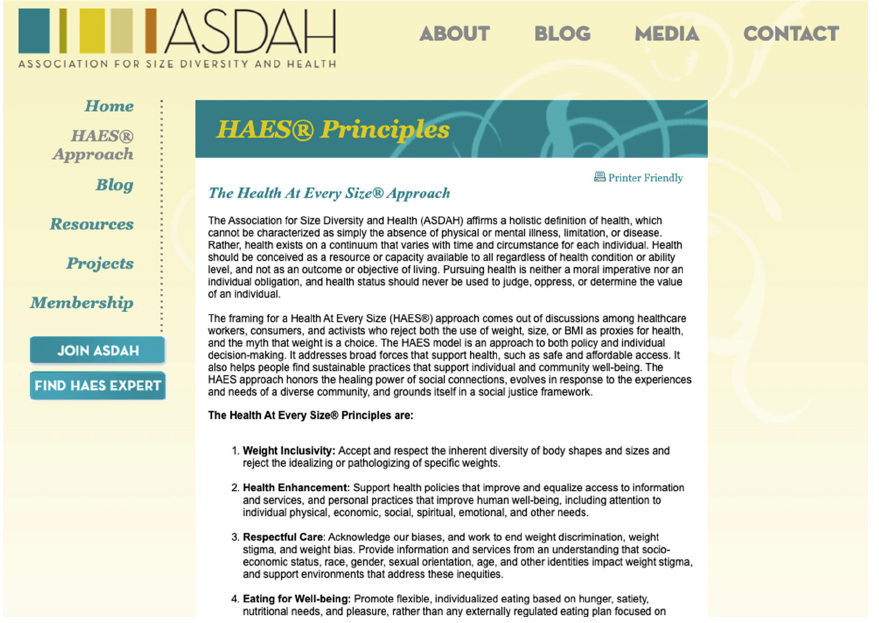
Figure 8. Association for Size Diversity and Health website, Healthy at Every Size page (https://www.sizediversityandhealth.org/, accessed on 2 November 2021).